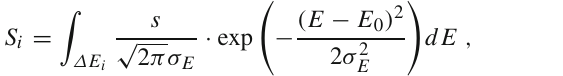
Fig. 3 Measured HPGe spectrum of the 0.181 g thorium sample obtained in 16.6 days (15.8 days livetime). Left: full spectrum with prominent γ -lines highlighted. Right: zoom in to the region of interest